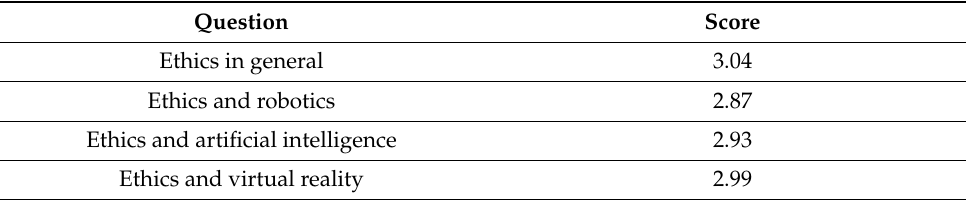
Table 2. Output from the Likert scale “Evaluate your university education in ethics in relation to the following